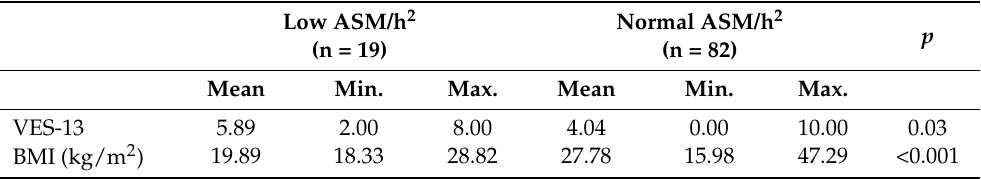
Table 8. Comparison of patients with to patients with normal